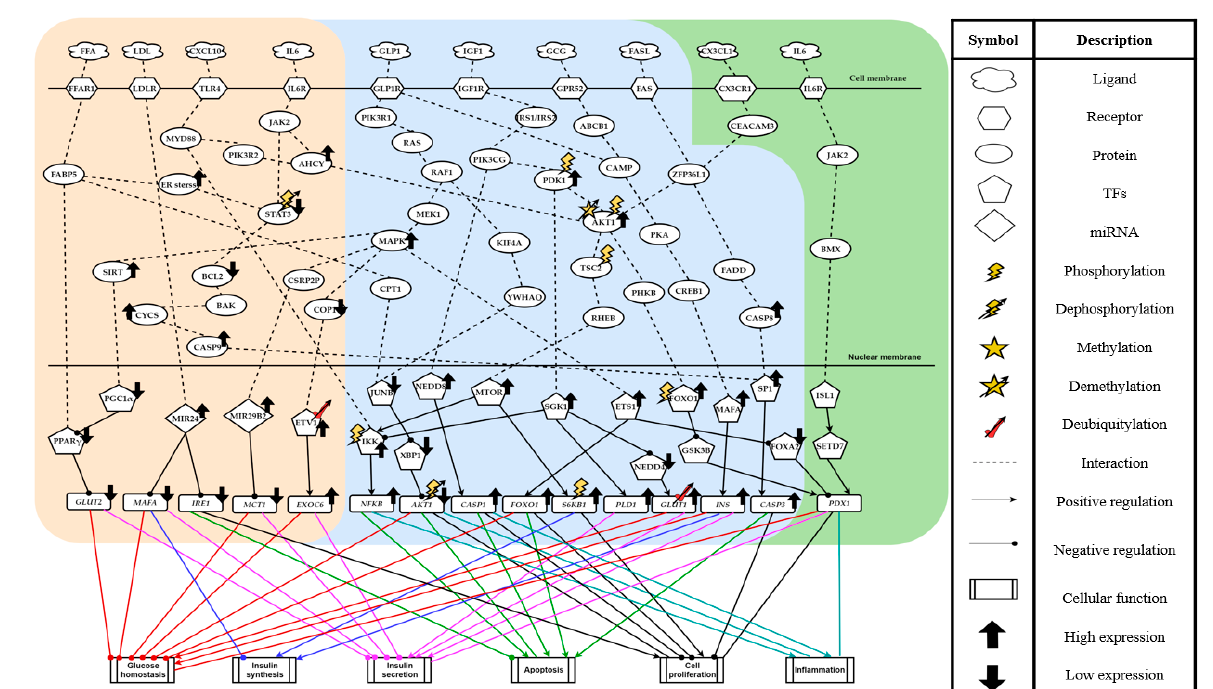
Figure 2. The T2D pathogenic mechanism investigation by comparing the T2D and non-T2D core signaling pathways. The genes and proteins in the core signaling pathways were chosen from the T2D and non-T2D core GWGENs. The gene regulations and protein interactions were constructed based on the edges in core GWGENs. The blocks of light orange, light blue, and light green background color separately indicate the T2D differential signaling pathways, the common signaling pathways of both T2D and non-T2D, and the non-T2D differential signaling pathways, respectively. The cellular functions caused by target genes are clustered with solid lines in different colors and referred to Uniprot. The bold arrowhead marks in black denote the relatively low and high expression in pathogenic signaling pathways in contrast to non-T2D.2.2. The Pathogenic Microenvironment in T2D.